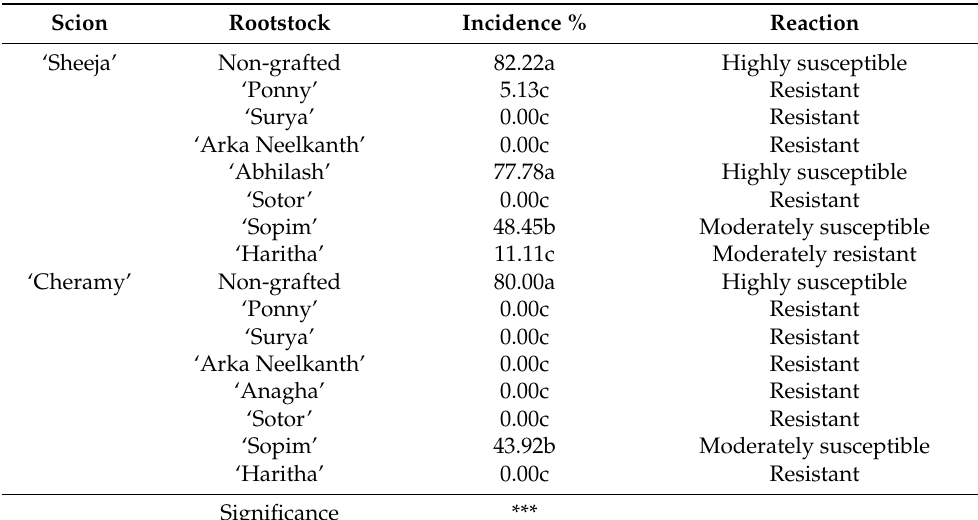
Table 2. Bacterial wilt disease incidence and reaction in different graft combinations of cherry tomato